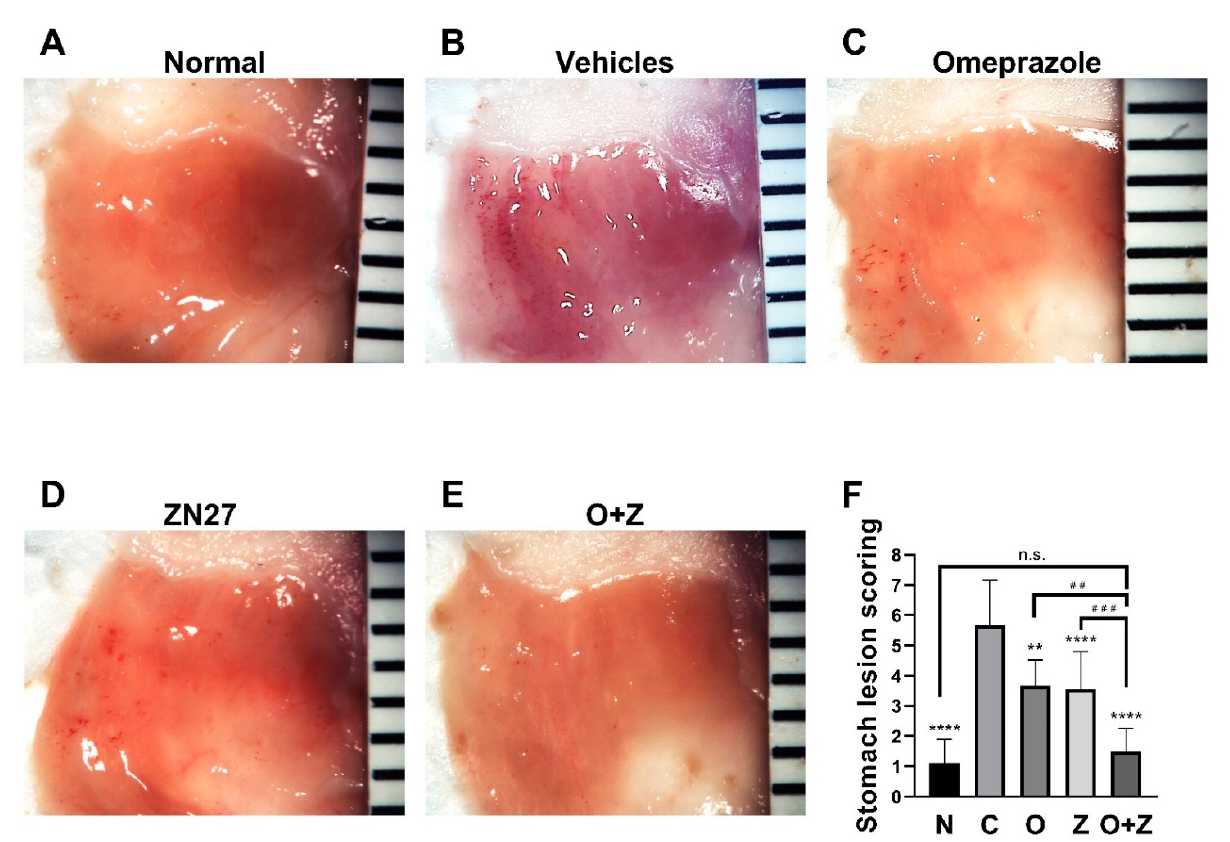
Figure 3. ZN27 promotes the healing of the aspirin-induced gastric injury in mice. Representative images of gastric lesions in mice receiving no treatment ( A ), vehicles ( B ), omeprazole ( C ), ZN27 ( D ), or omeprazole/ZN27 ( E ) at day 6, respectively. ( F ) Gastric lesion scoring in mice receiving no treatment ( n = 9), omeprazole ( n = 9), ZN27 ( n = 18), or omeprazole/ZN27 ( n = 8) are compared with gastric lesion scoring from vehicles-treated mice ( n = 12) at day 6 (** p <0.01, **** p < 0.0001). Gastric lesion scoring in mice treated with Zn27, alone ( n = 18), and omeprazole, alone ( n = 9), are compared with lesion scores from mice treated with omeprazole and ZN27 together ( n = 8) at day 6 ( ## p < 0.01, ### p < 0.001). Normal ( N ), vehicles (C), omeprazole (O), ZN27 (Z), and omeprazole/ZN27 (O + Z). (n.s. means not statistically significant.)